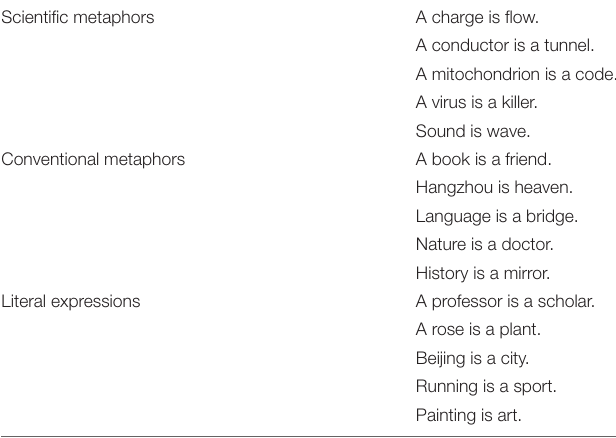
TABLE 2 | Sample English stimuli.